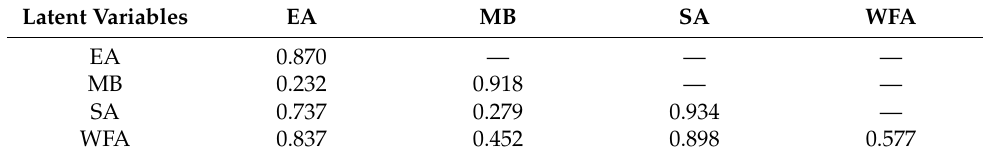
Table 2. Discriminant convergent validity among latent